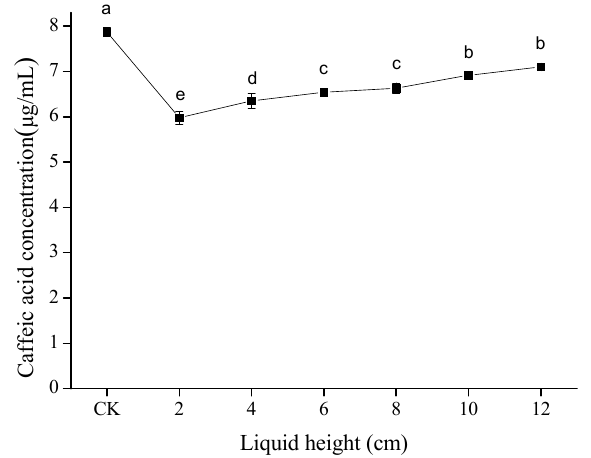
Different letters on the line indicate significant differences ( p <